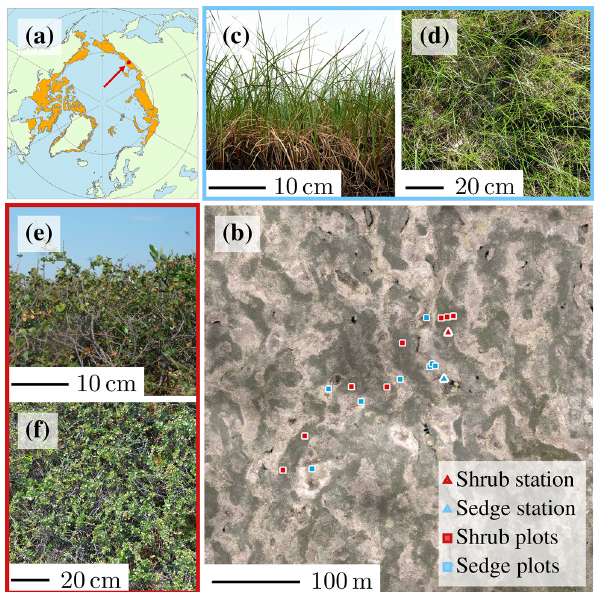
Figure 1. (a) Location of the Kytalyk research station and Arctic tundra extent (data from Walker et al., 2005), (b) red-green-blue or- thomosaic of the site (drone flight July 2014) where shrubs appear as dark surfaces, while sedges are represented by bright shades in- cluding the locations of stations for time series and distributed plot measurements on dwarf shrubs and wet sedges, (c, d) sedge vegeta- tion and (e, f) dwarf shrub